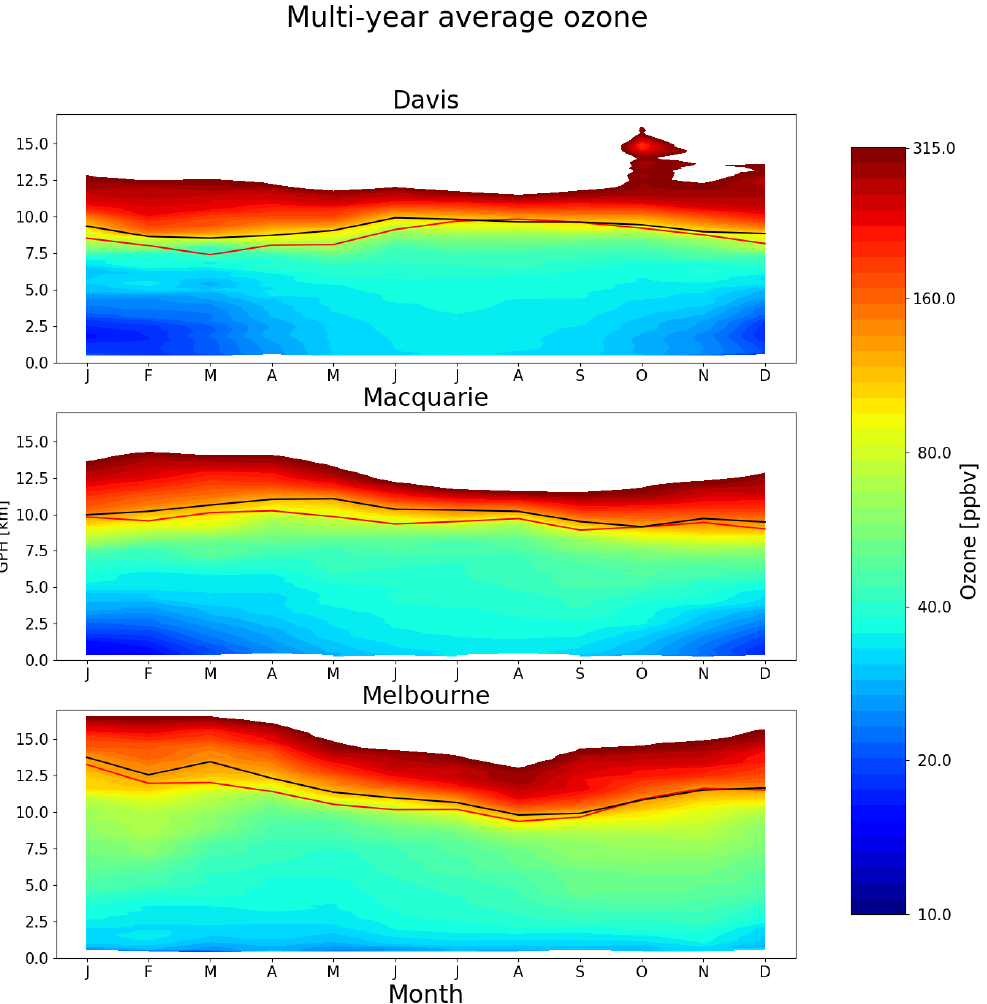
Figure 3. Multi-year mean seasonal cycle of ozone mixing ratio over Davis, Macquarie Island, and Melbourne as measured by ozonesondes. Measurements were interpolated to every 100m and then binned monthly. Black and red solid lines show median ozone and lapse-rate-defined tropopause altitudes (respectively), as defined in the